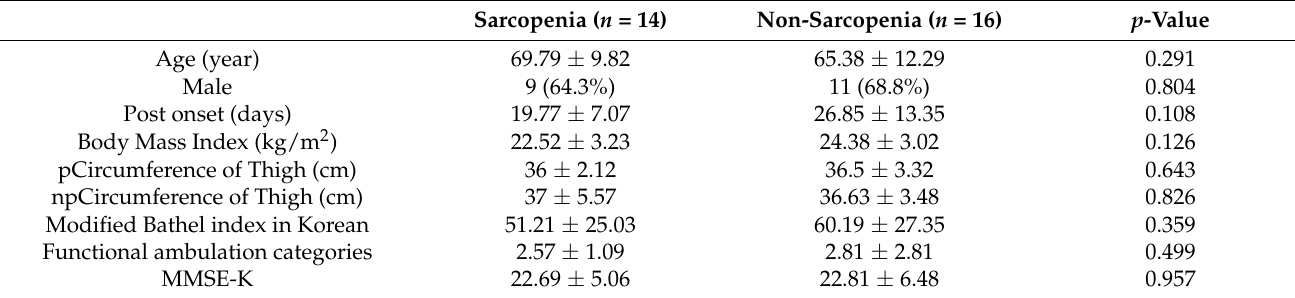
Table 1. Clinical characteristics between subjects with and without sarcopenia.